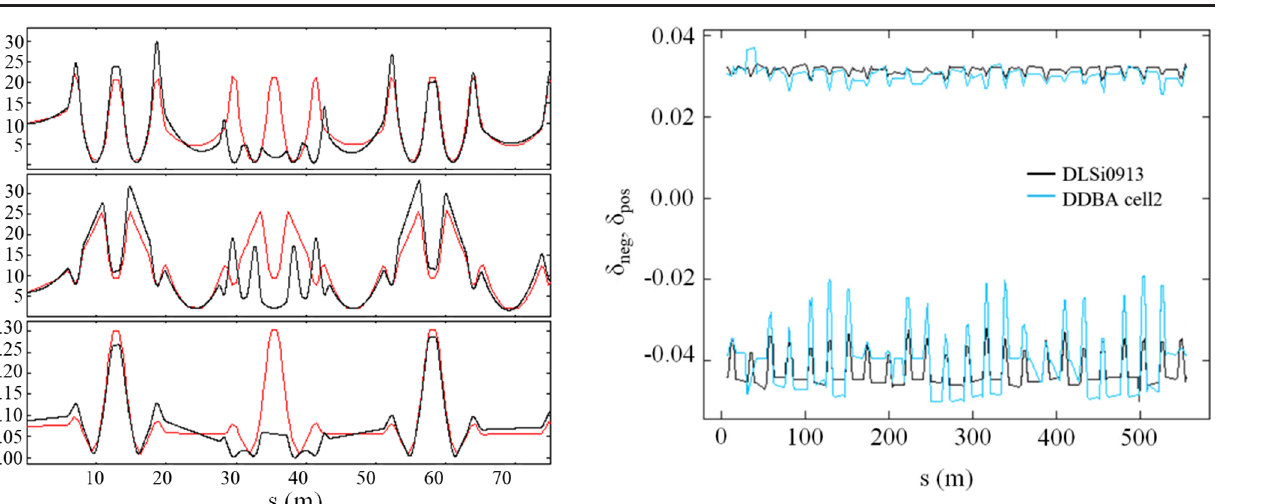
FIG. 3. Cell 2 optics matched to the existing adjacent cell: DBA optics (red) new optics (black).